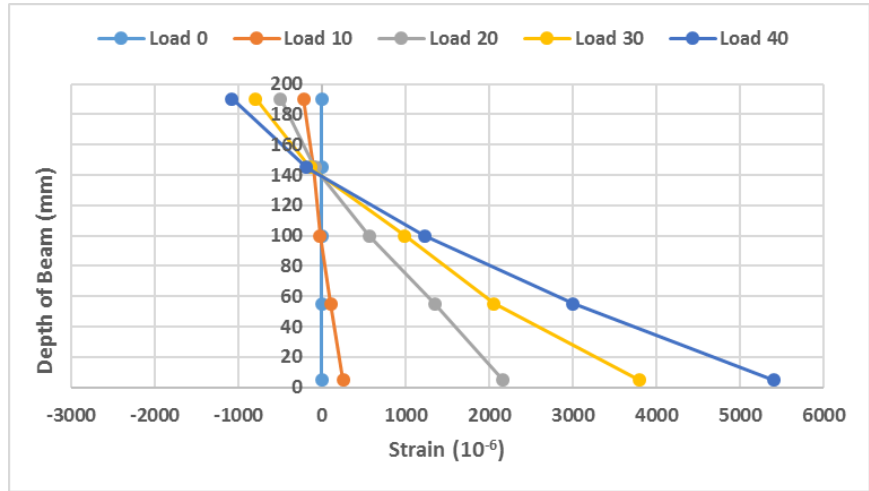
Figure 12. Depth of neutral axis for specimen RF.